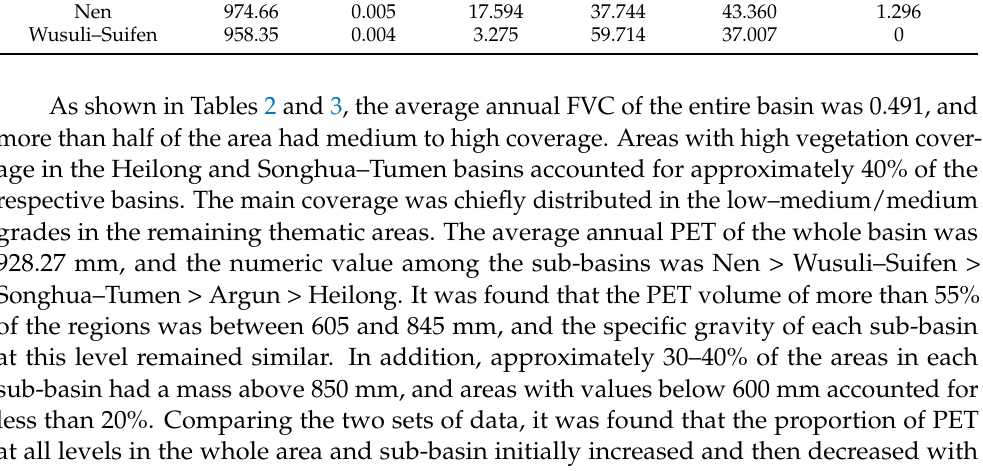
Table 3. Basin/sub-basin mean Potential evapotranspiration (PETs) and class ratios. (Sub) Basin